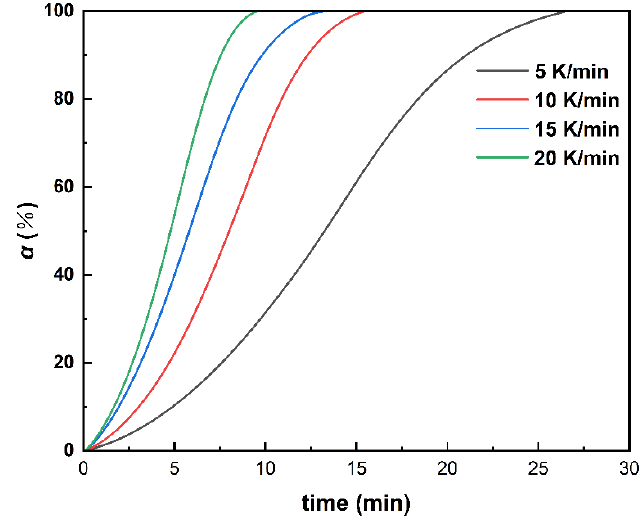
Figure 2. Relationship of the curing degree and time under different heating rates. A linear relationship was obtained by fitting ln( β / T p2 ) to 1/ T p in Figure 3. The values of E a and A can be obtained by the Kissinger method in Figure 3, which gives the activation energy E a = 46.34 kJ · mol -1 , the pre-exponential factor A = 1.01 × 10 6 min − 1 , and the correlation coefficient R 2 =